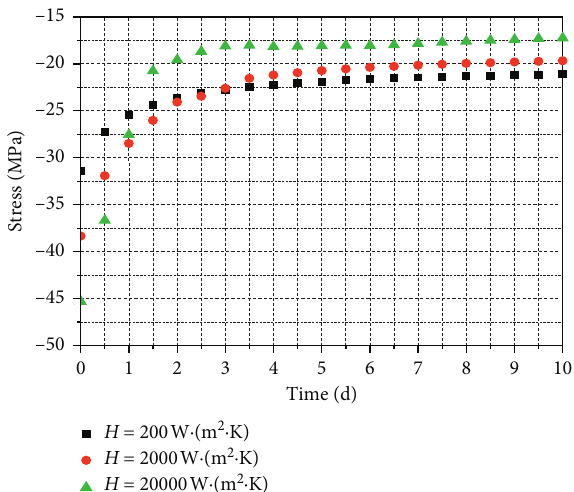
Figure 9: Evolution rule of chamber stress with time under dif- ferent convective heat transfer coefficients.